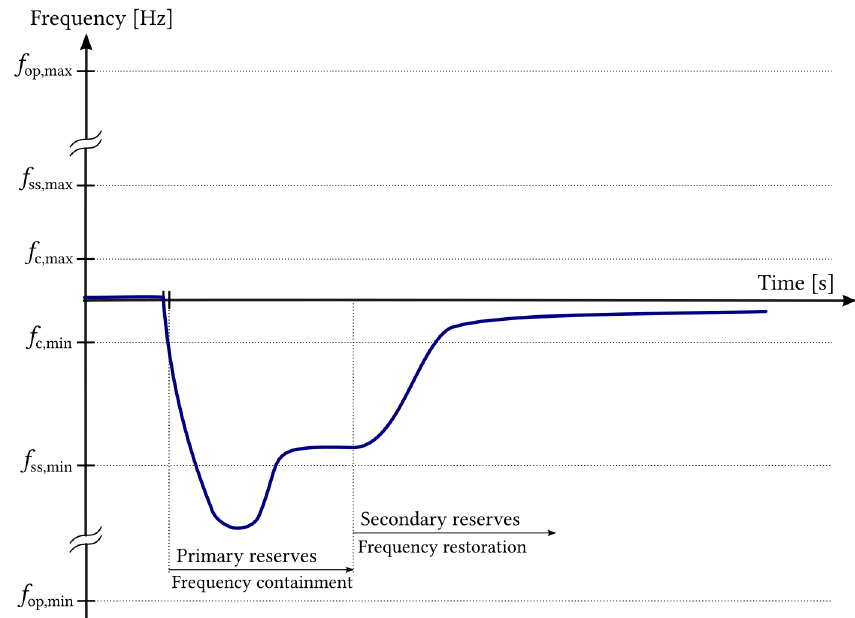
Figure 3. Operating reserves activation in the event of a loss of generation in an electric power